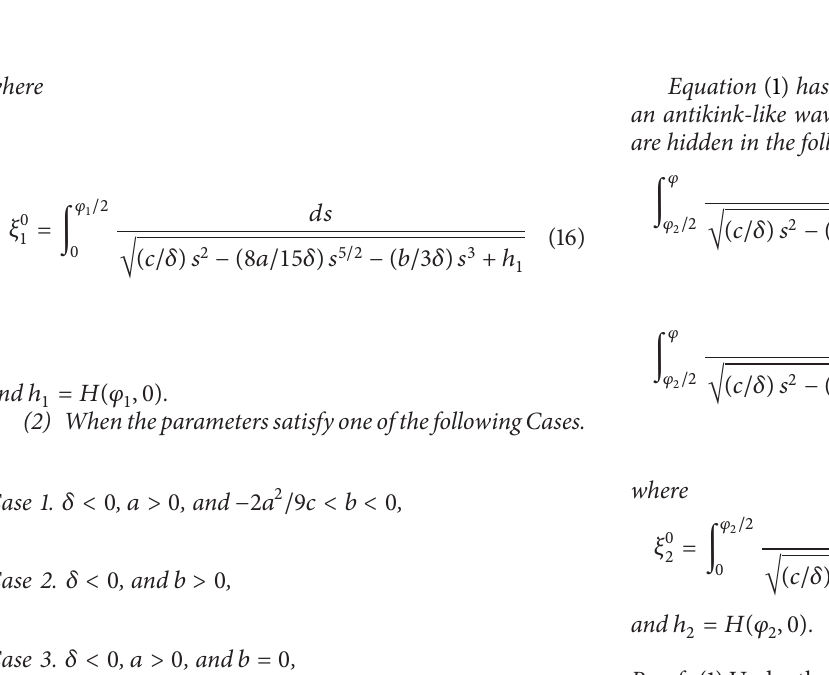
Figure 9: (The kink wave is bifurcated from the blow-up wave). The varying process for the graph of 𝑢 𝑑 when 𝑐 > 0 , 𝛿 > 0 , 𝑎 > 0 , 𝜆 > 0 , and 𝑏 → −16𝑎 2 /75𝑐 − 0 , where 𝑐 = 1 , 𝛿 = 1 , 𝑎 = 1 , 𝜆 = 1 , and (a) 𝑏 = −16𝑎 2 /75𝑐 − 10 −2 . (b) 𝑏 = −16𝑎 2 /75𝑐 − 10 −4 . (c) 𝑏 = −16𝑎 2 /75𝑐 − 10 −5 . (d) 𝑏 = −16𝑎 2 /75𝑐 − 10 −9